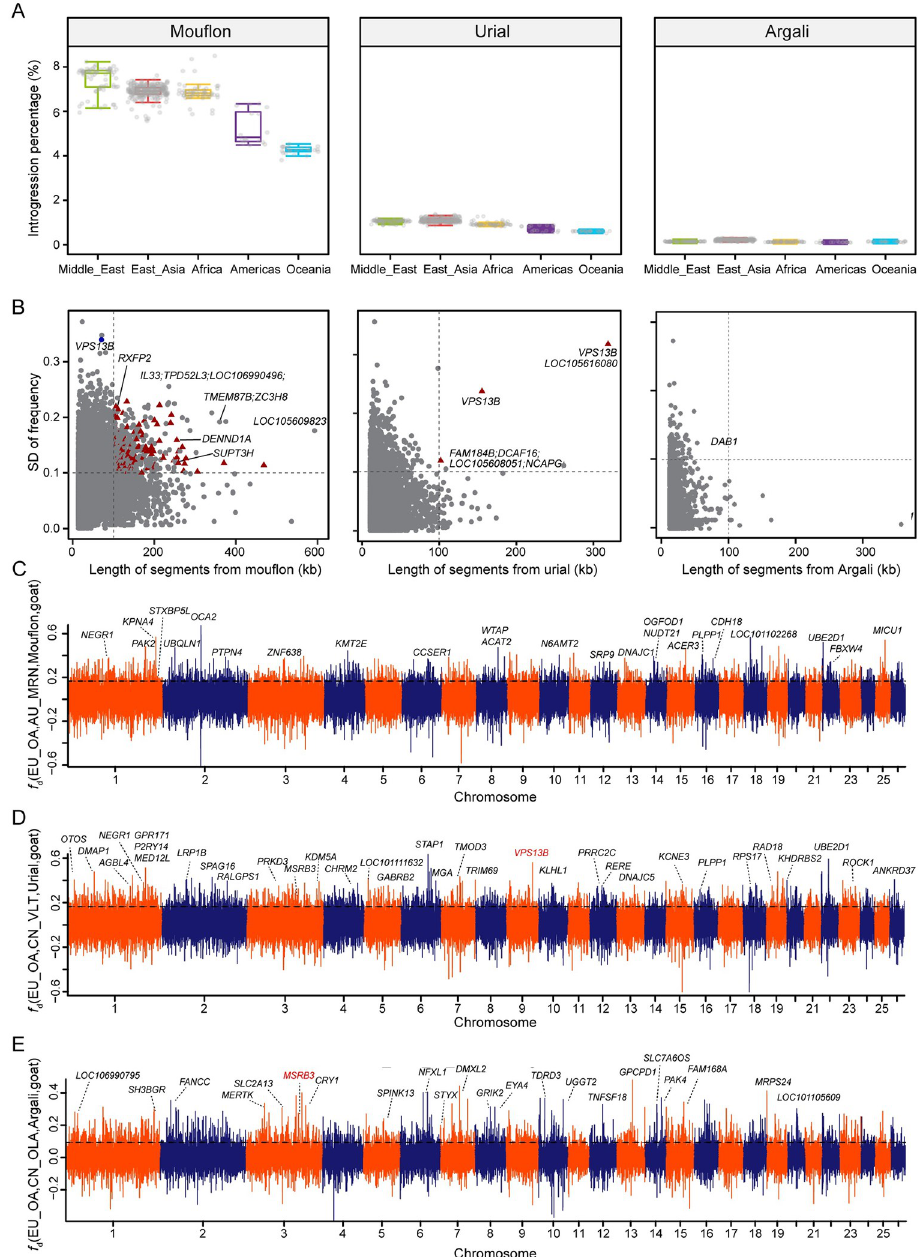
Fig 3. Genome-wide introgression evaluation and potential adaptive introgression. (A) The proportions of introgressed sequences from wild relatives (Iranian mouflon, urial and argali) identified in each domestic population. Each dot indicates a phased haploid. (B) Joint distribution of length for introgressed tracks (x axis), SD for introgressed haplotype frequency among distinct populations (y axis). Red triangles indicate tracts with significant high F ST values ( P < 0.001, Z test) between at least one of the 16 domestic meta-populations and Iranian mouflon. (C-E) Manhattan plot of values showing the introgression signals from Iranian mouflon to Australian Merino (C), from Urial to Valley Tibetan sheep (D) and from Argali to Tibetan Oula sheep (E). The horizontal dashed line indicated the P < 0.05